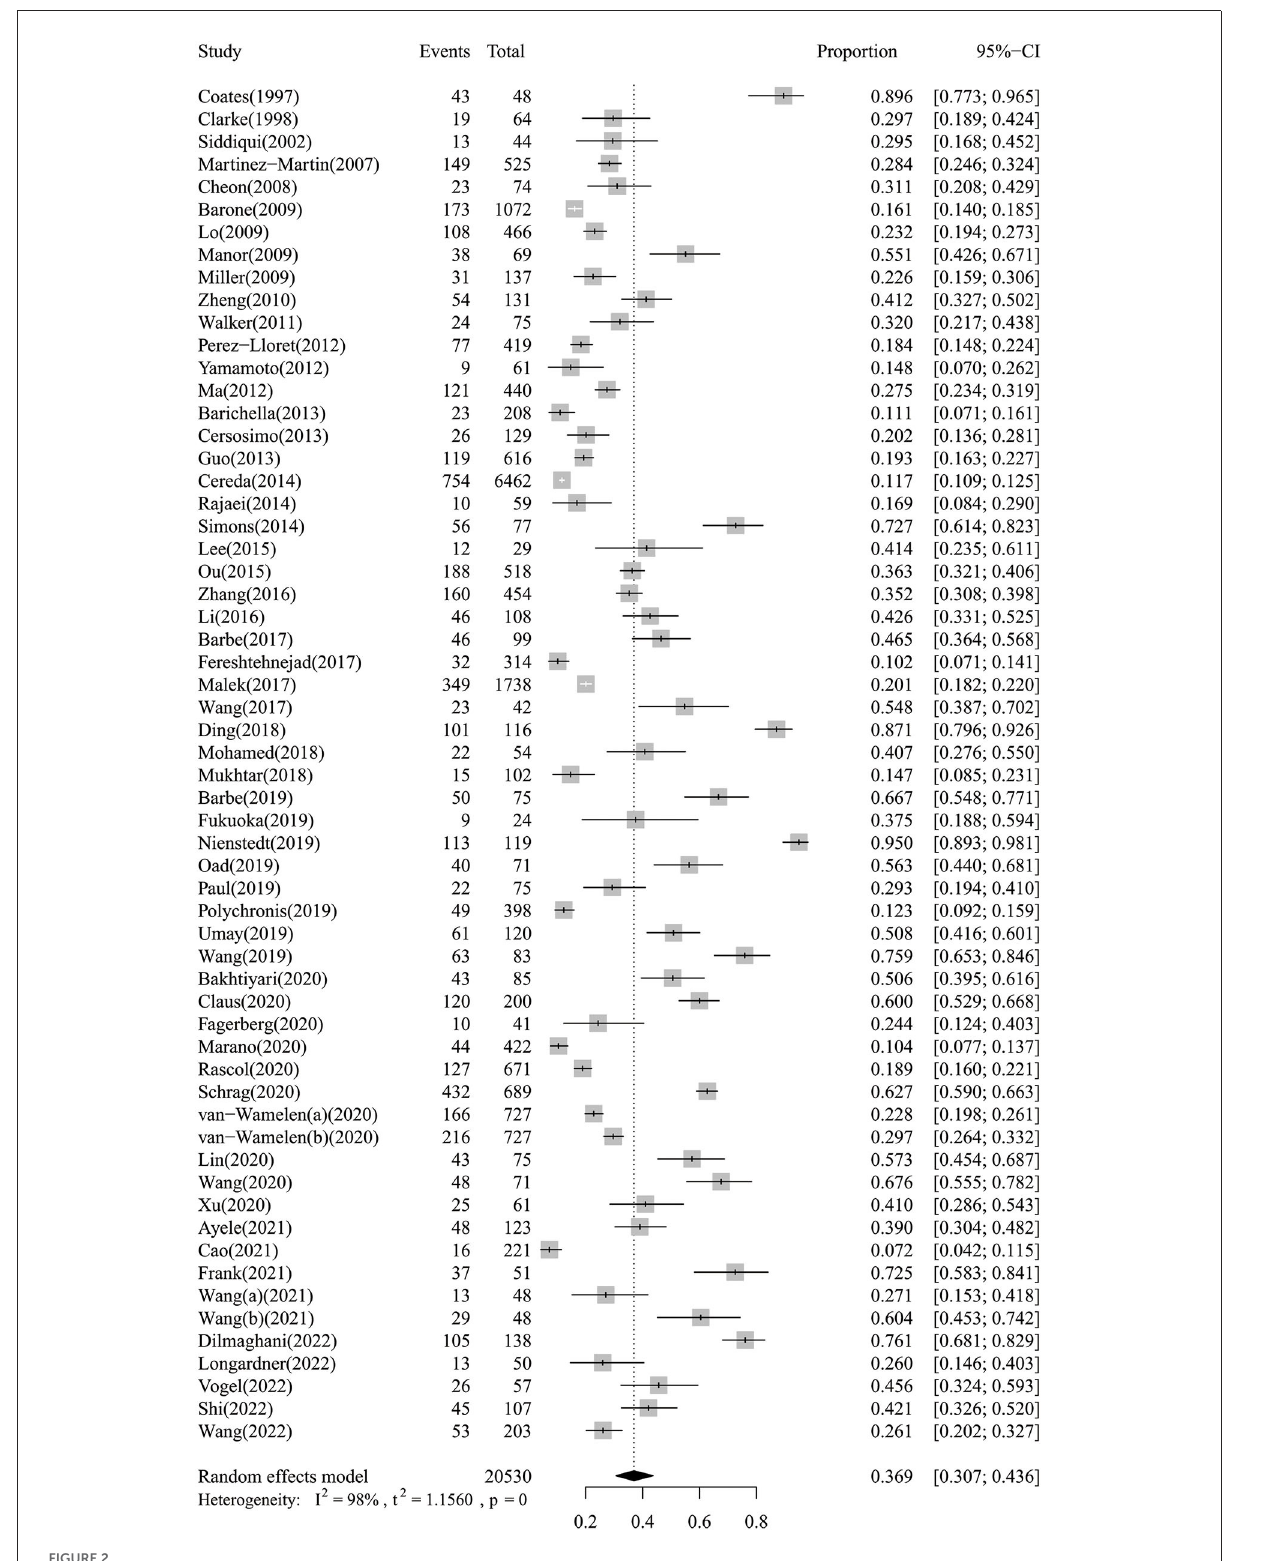
FIGURE2 The forest plot of the overall prevalence of dysphagia in